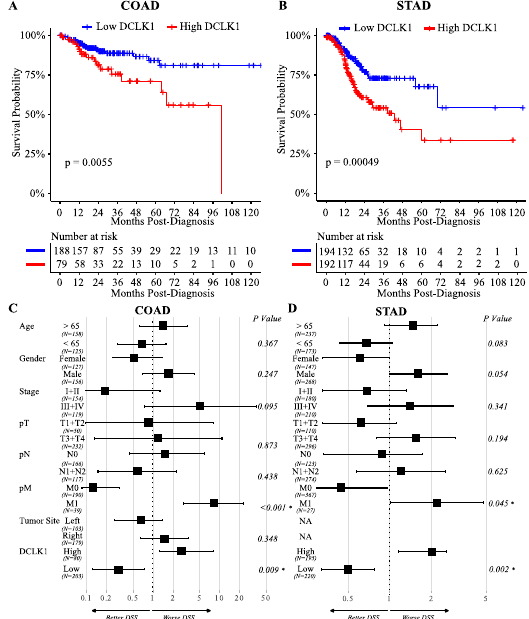
Figure 1. DCLK1 is an independent risk factor to predict disease-specific survival (DSS) of colon and gastric cancer. Lower DCLK1 mRNA expression significantly predicts shorter DSS in COAD ( n = 283) ( A ) and STAD ( n = 415) ( B ) based on Kaplan–Meier analysis. Multivariate Cox regression analysis of